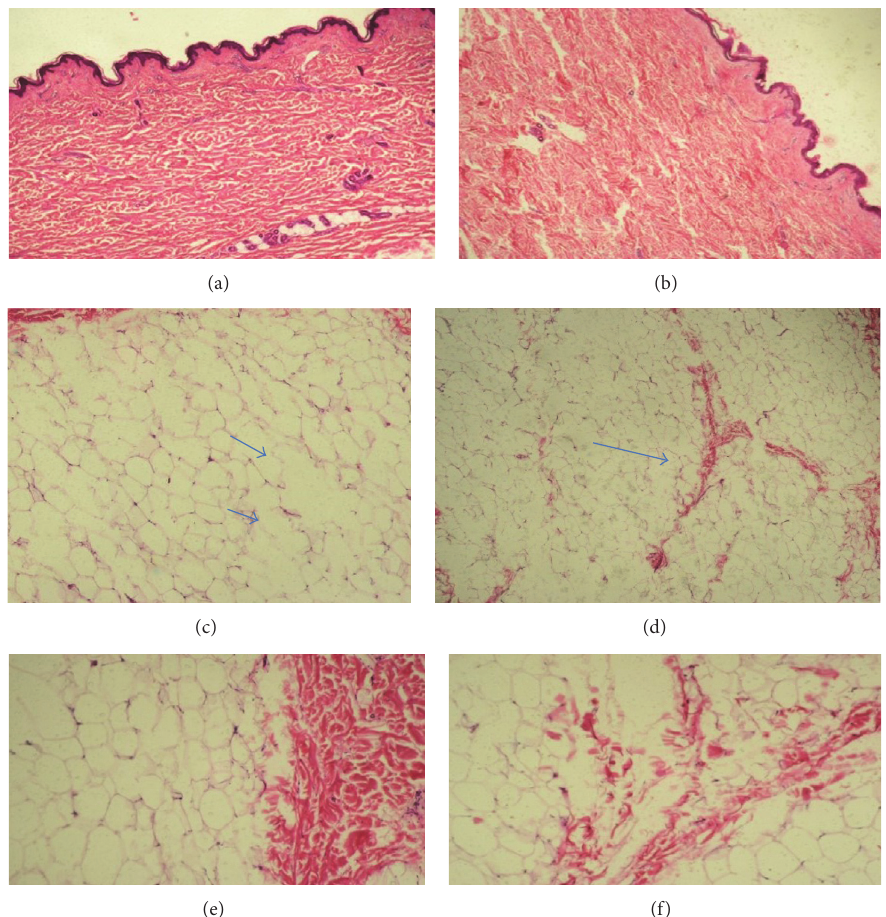
Figure 9: Microscopic analysis of the material collected during the abdominoplasty. Longitudinal micrograph HE 100x (a) untreated region and (b) treated region. Longitudinal micrograph HE 100x (c, d) adipocytes membranes destruction and fibrosis in the midst of the adipose tissue. (e, f) Longitudinal micrograph HE 400x treated area with preserved adjacent tissue and fibrosis in the midst of the adipose